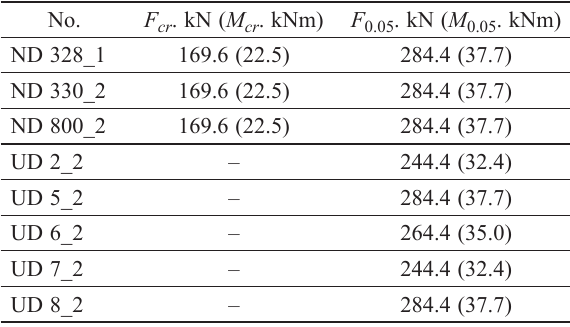
Table 5. Summary of dynamic test results